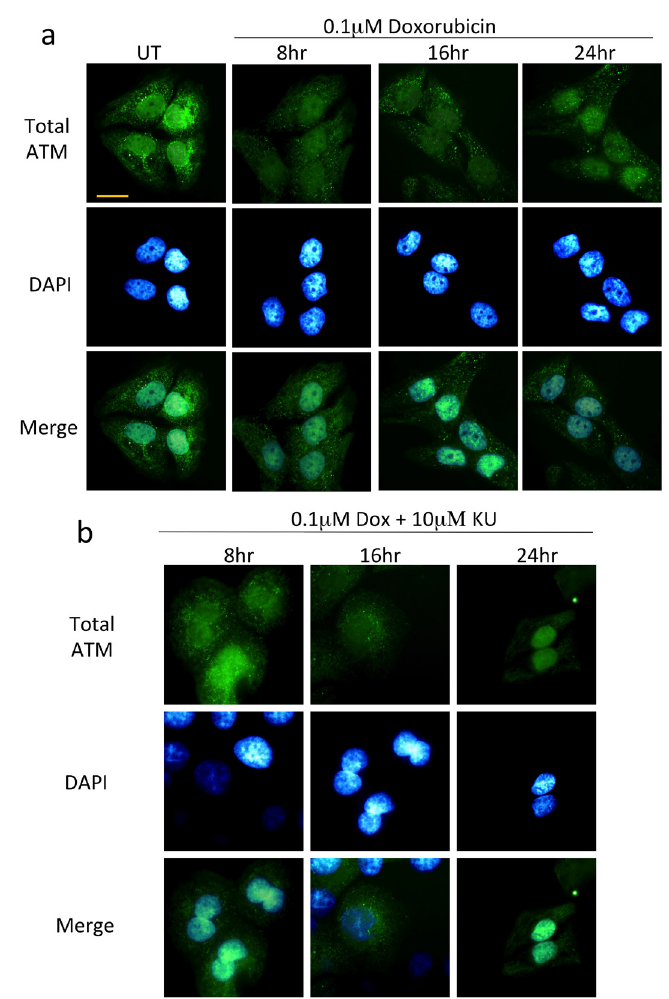
Figure 4. Double stranded DNA damage induces time dependent nuclear foci formation of ATM with no change in its total levels. Immunofluorescent labelling of endogenous ATM was performed by seeding 0.5x10 5 cells on to poly L lysine coated coverslips placed in 12-well tissue plates for 18 h. Following this, cells were either left untreated or treated with 100nM Dox alone (a) or with 100nM Dox and 10μM KU (b) for the indicated time and further processed for immunocytochemistry as described in materials and methods. To stain endogenous ATM, cells were incubated with anti ATM primary antibody (see antibody table) followed by using Alexa Fluor® 488 (green fluorescence) conjugated secondary antibody (Invitrogen). To show nuclear co-localisation, cells were stained with 4’, 6-Diamidino- 2-phenylindole, Dihydrochloride (DAPI). These are representative images captured in different field of views under 100x objective with relevant filters sets using Leica DMiRe2 electronic microscope. Scale bar represents